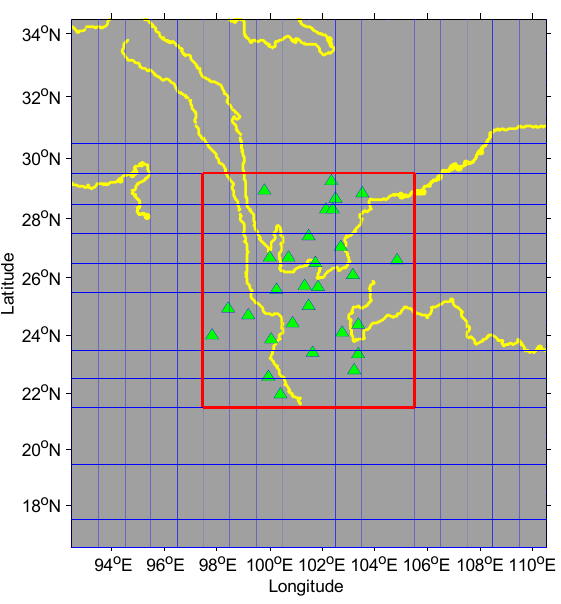
Figure 5. Plots of the grid cells (with 1° × 1° size) and GPS station locations. The core area is inside the red box and the outside is the additional area.